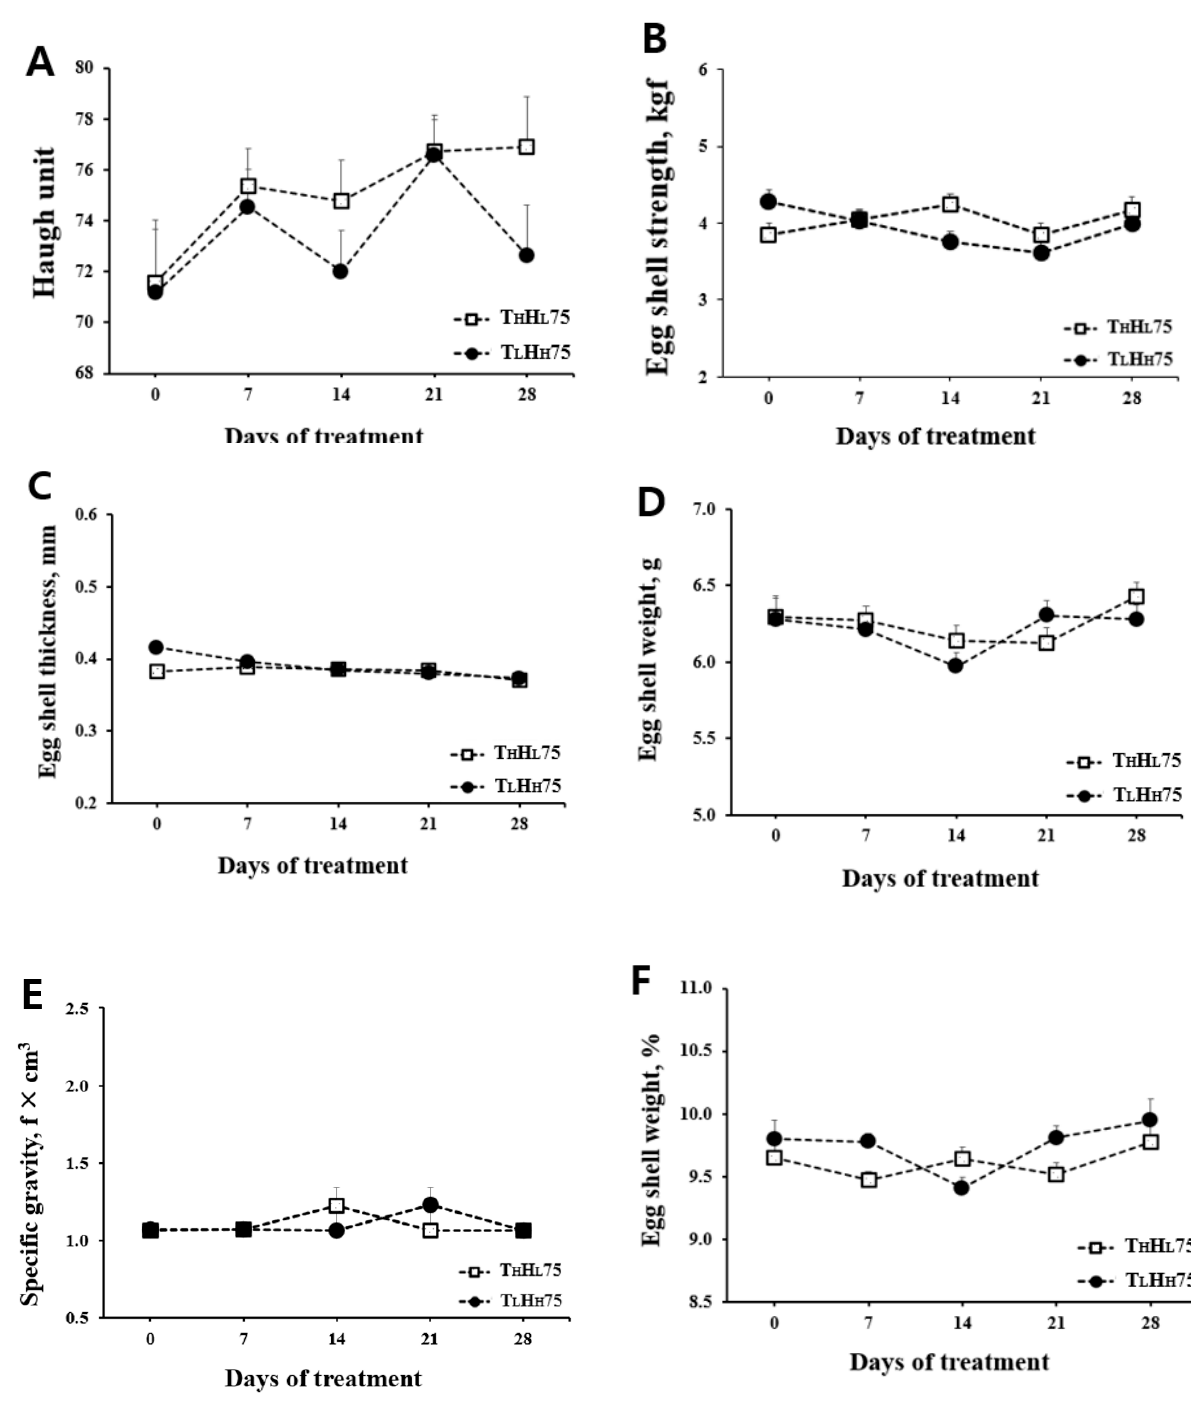
Figure 2. Effect of different ambient temperatures and humidity (same temperature-humidity Index) on egg quality. Laying hens were exposed to two ambient temperature conditions (26 ◦ C, 70%; 30 ◦ C, 30%). Error bars indicate the standard deviation of the mean ( n = 10). T L H H 75 = temperature 26 ◦ C; relative humidity 70%; T H H L 75 = temperature 30 ◦ C; relative humidity 30%. ( A ) Haugh unit. ( B ) Eggshell strength (kgf). ( C ) Eggshell thickness (mm). ( D ) Eggshell weight (g). ( E ) Specific gravity (f × cm 3 ). ( F ) Eggshell weight (%).